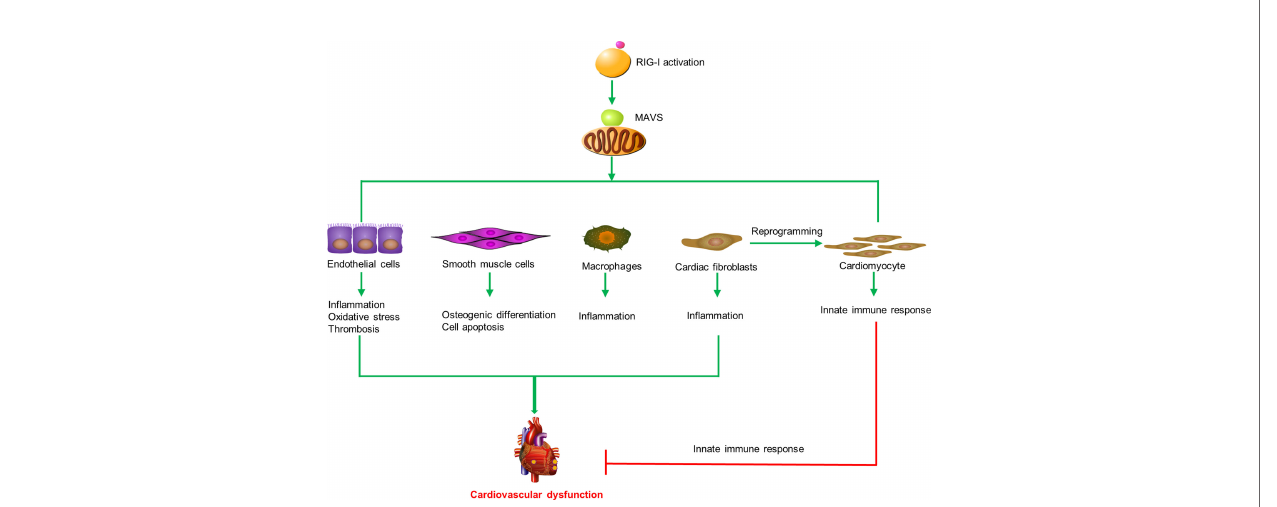
FIGURE 2 | RIG-I triggers the innate immune response and participates in cardiovascular diseases. RIG-I is activated by activators and interacts with MAVS to trigger in fl ammatory responses, cell apoptosis, oxidative stress, prothrombotic proteins expression, osteogenic differentiation in macrophages, endothelial cells, smooth muscle cells, and cardiac fi broblasts to promote cardiovascular dysfunction. Otherwise, RIG-I activation mediates the remodeling of scar fi broblasts into cardiomyocytes and prevents cardiac hypertrophy by enhancing the innate immune